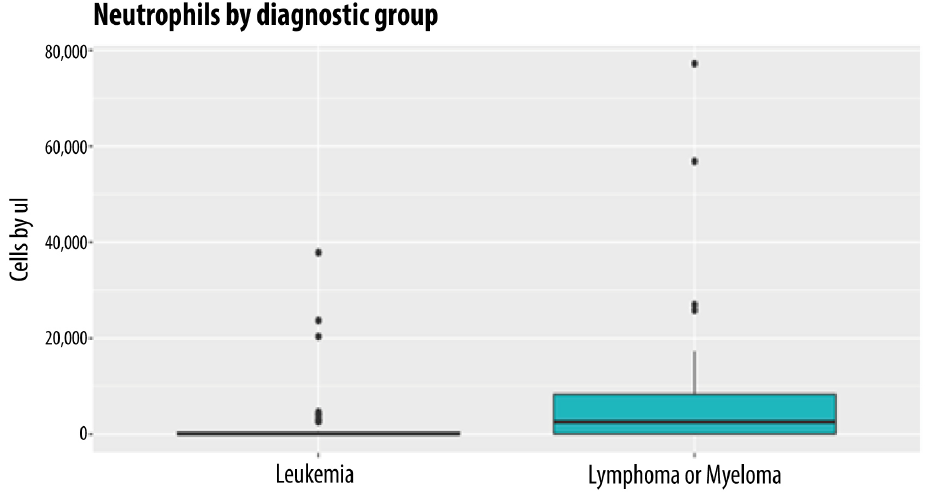
Figure 1. Neutrophil count by diagnostic group.